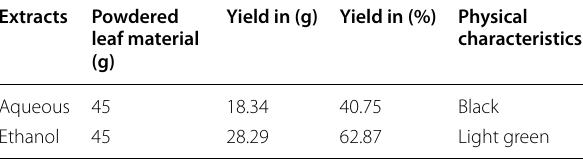
characteristics